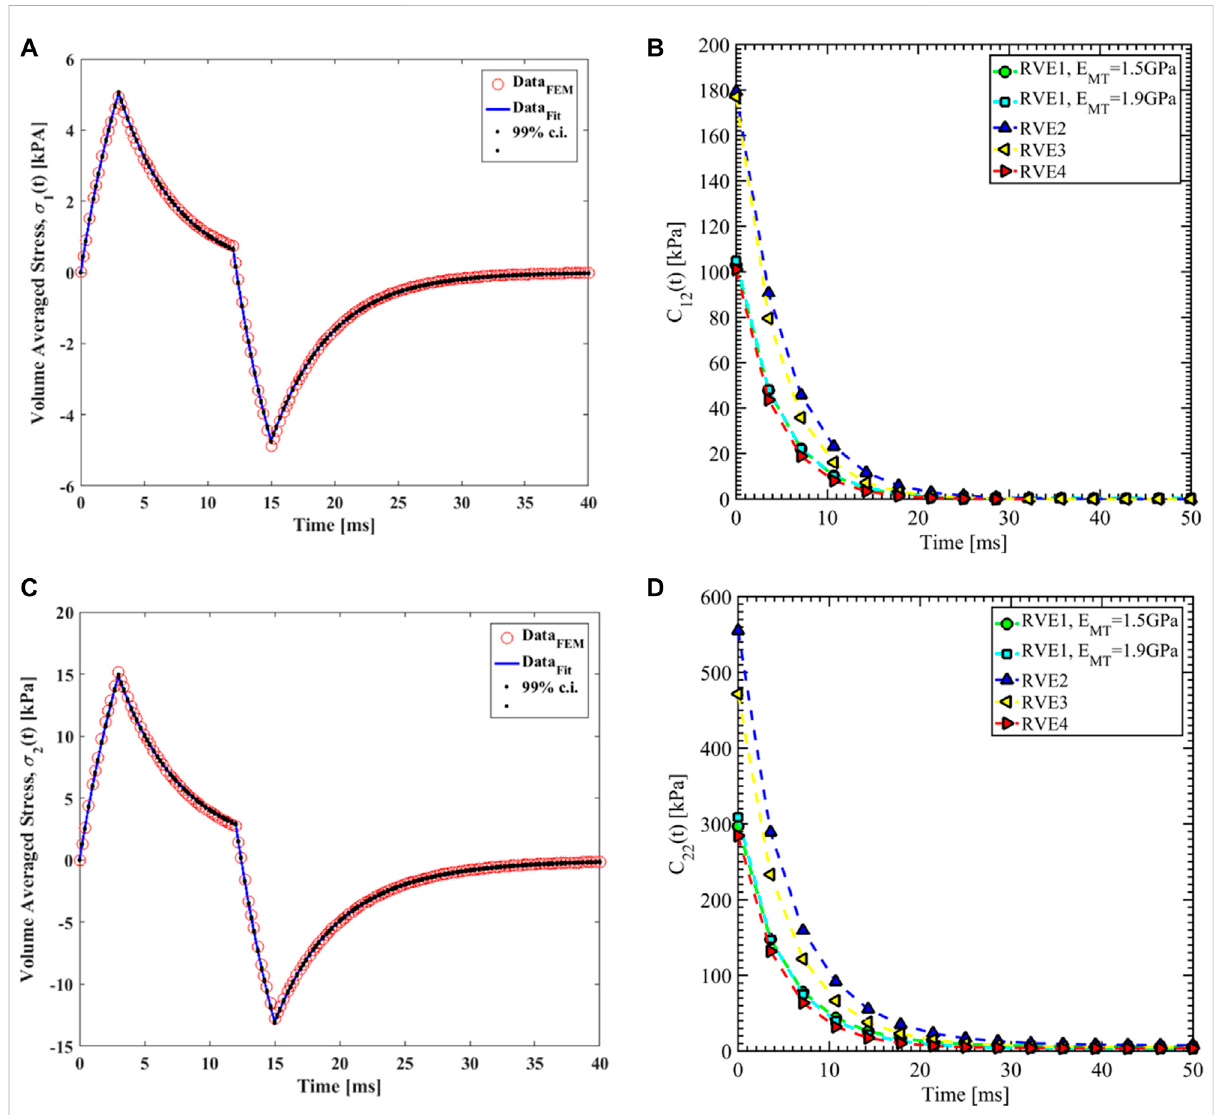
FIGURE 10 (A) Nonlinear regression data fi t with 99% con fi dence interval (c.i.) is shown for volume averaged normal stress in direction 1 for RVE-1, E MT (cid:2) 1 . 5 GPa forloadcase2. (B) Comparisonof C 12 ( t ) fordifferentRVEs. (C) Nonlinearregressiondata fi twith99%con fi denceinterval(c.i.)isshown for volume averaged normal stress in direction 2 for RVE-1, E MT (cid:2) 1 . 5 GPa for load case 2. (D) Comparison of C 22 ( t ) for different